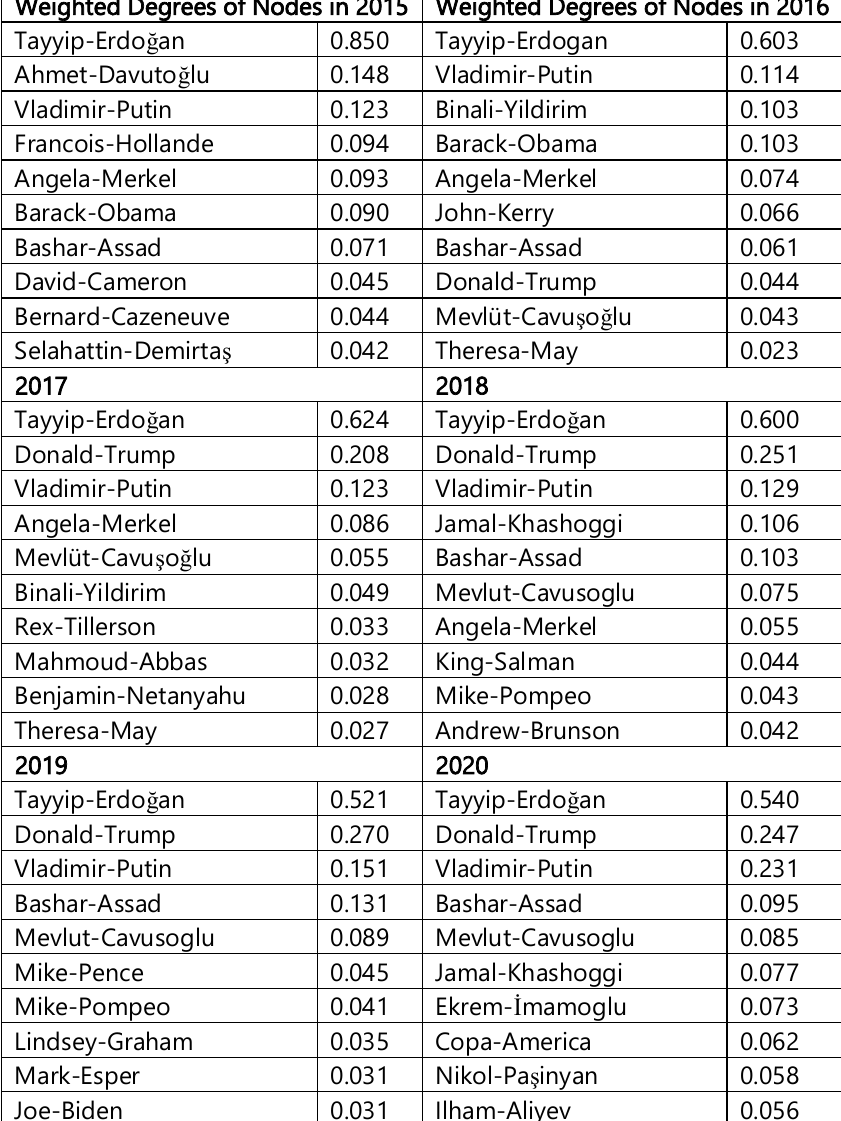
Table 1: Weighted Degrees of Nodes between 2015 and 2020 (Source: Authors ‟ depiction) Weighted Degrees of Nodes in